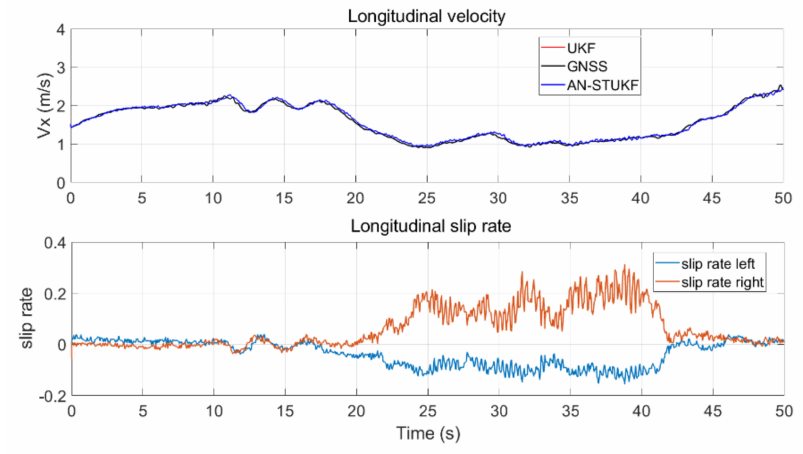
Figure 9. The longitudinal state when a skid-steered wheeled vehicle turns in a small radius. The lateral velocity, yaw rate, and tire sideslip angle estimation results are shown in Figure 10. The two estimation algorithms perform almost similarly when observing yaw rate, because yaw rate is the measurement value. In this study, the yaw rate calculated by the encoders’ data is also compared with the observer result which is the cyan line shown in Figure 10. The calculated result by the encoder is larger than the real values because it ignores the longitudinal slip rate. The result calculated by encodes verifies that simple longitudinal velocity and yaw rate calculating method only using an encoder is not accurate enough when the vehicle driving is in strong nonlinear conditions.